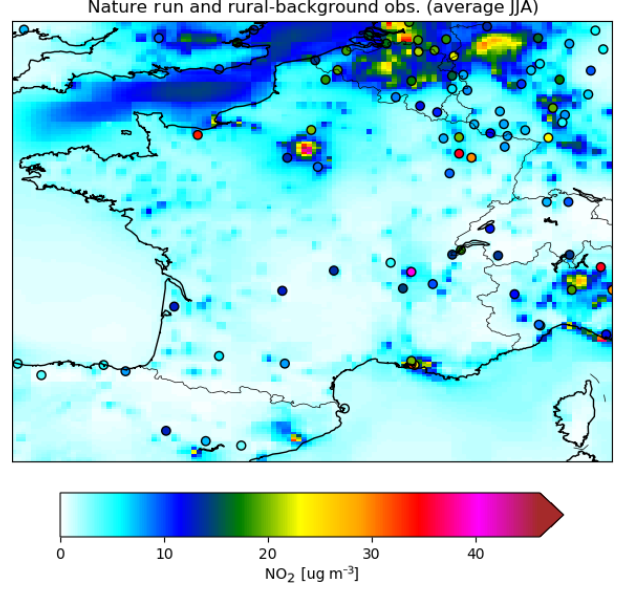
Figure 9. Average NO 2 concentrations over zoom domain for NR (background) for summer study period. Coloured dots indicate av- eraged real observation